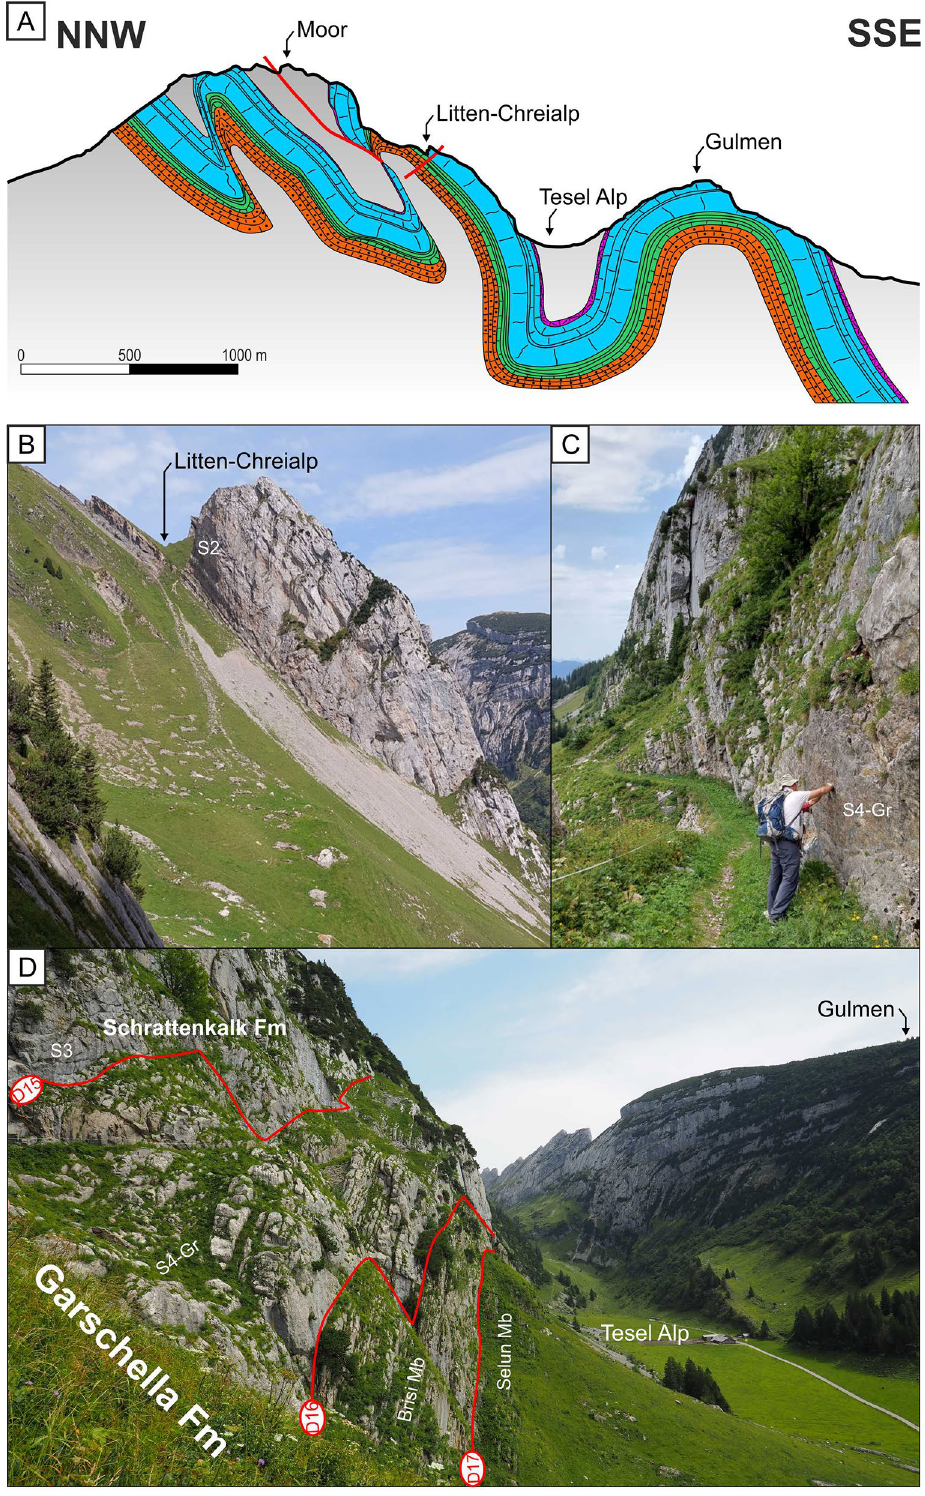
Fig. 13 A Geological cross-section between Moor and Gulmen modified after Kempf (1966). The colours refer to Fig. 1. B North eastward view on the Litten-Chreialp section from Chridegass. C South-westward view on the slightly overturned fold along the path from Eggsteihalde to Wildhuser Schofbode where the Grünten Member is easily accessible. D North eastward view on the Garschella Formation, from the same